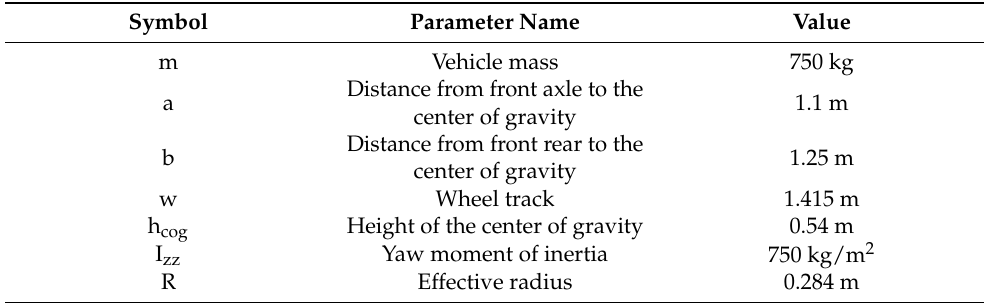
Table 1. Simulation vehicle parameter